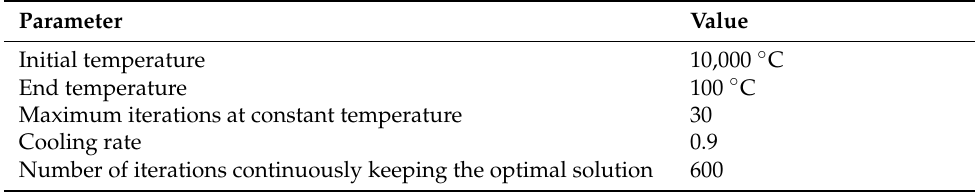
Table 2. The parameters related to simulated annealing algorithm.